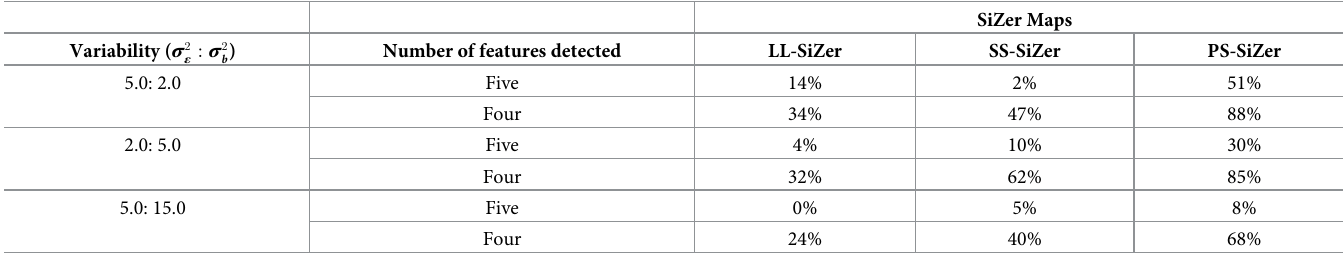
Proportions are from 50 simulation data